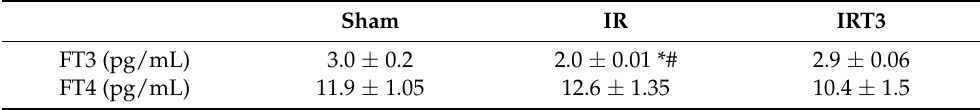
Table 1. Plasma level of free T3 and T4 at 3 d